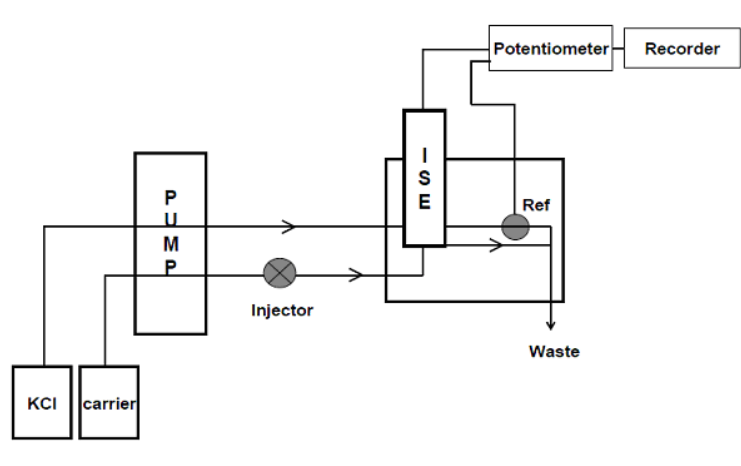
Figure 2. Schematic diagram of the FIA